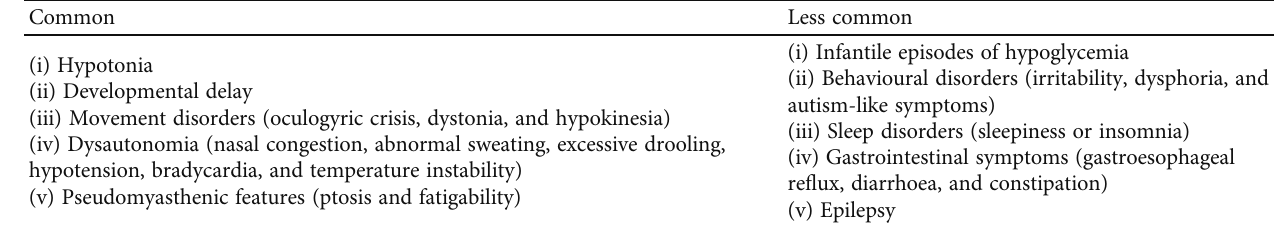
Table 1: Signs and symptoms reported in patients with AADC de fi